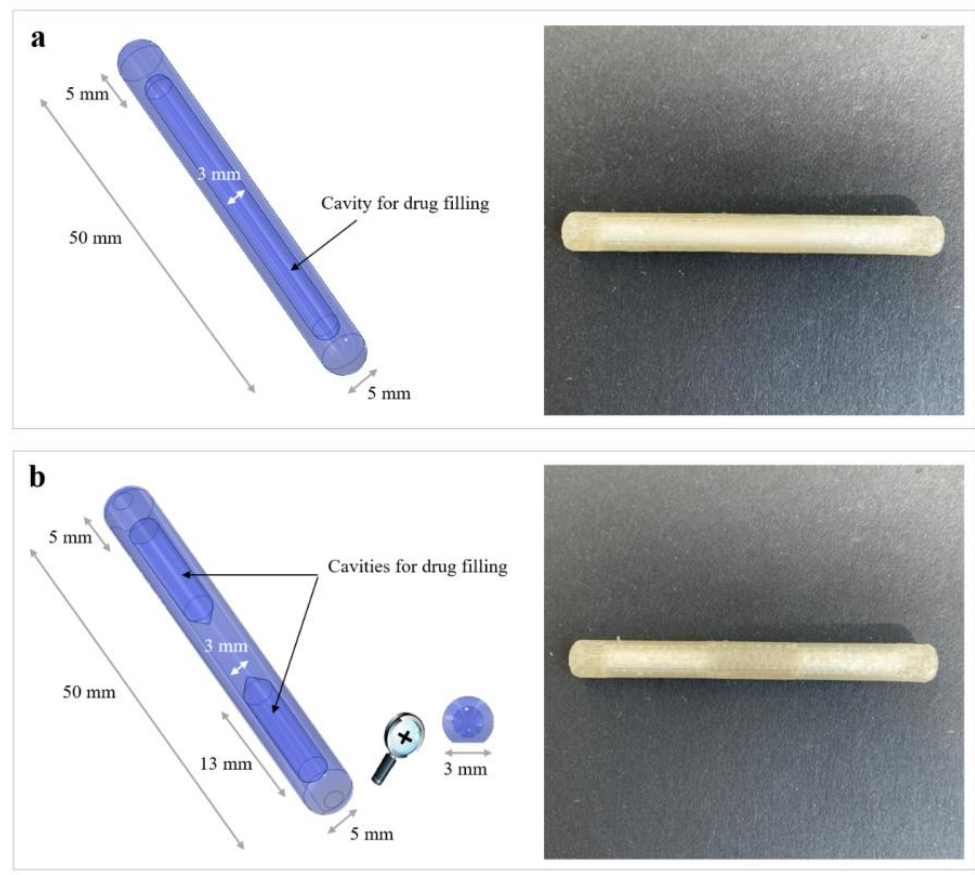
Figure 7. Digital models with dimensional and geometric details of ( a ) single and ( b ) two-compartment I-shaped prototypes, together with photographs of the actual printed and filled samples.